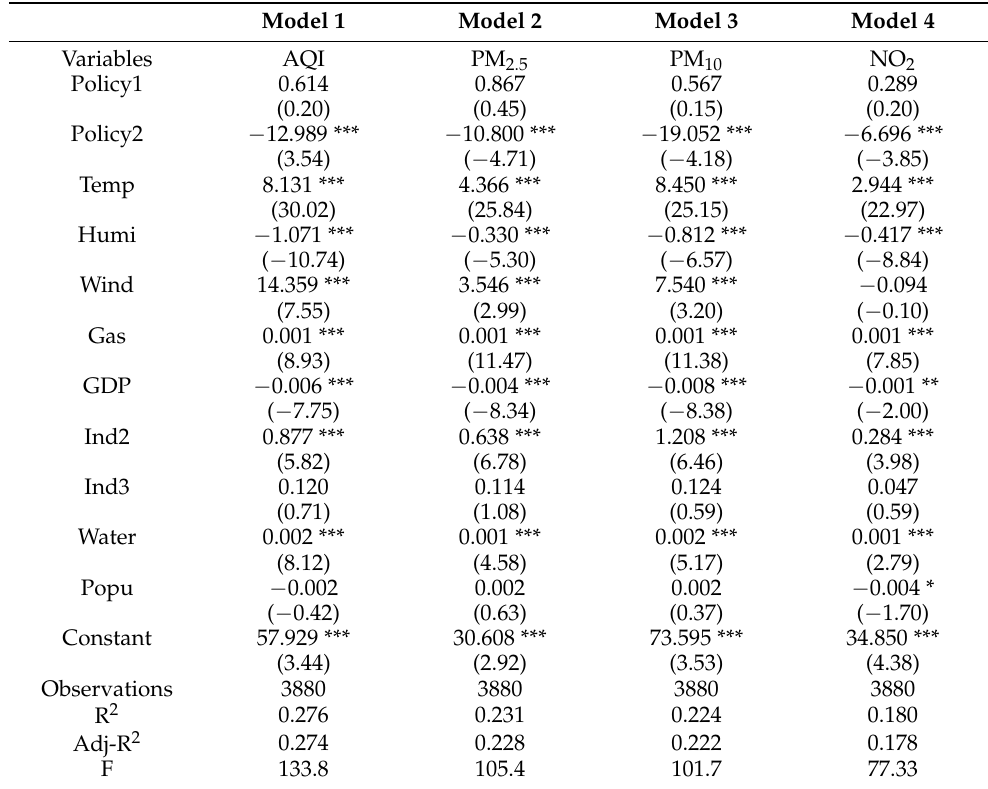
Table 6. Dynamic effect